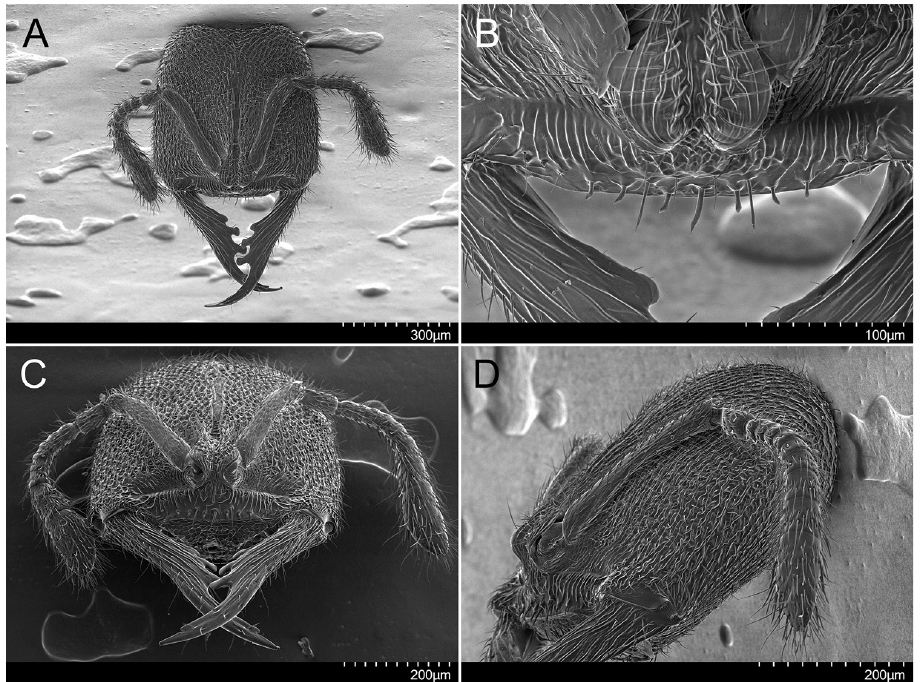
Figure 2. Holotype of Stigmatomma luyiae sp. n. (CASENT0922349); worker. Images by FAE; available at AntWeb.org. A Full-face view B Anterior margin of clypeus, dorsal view C Mandibles, anterior view D Head, lateral